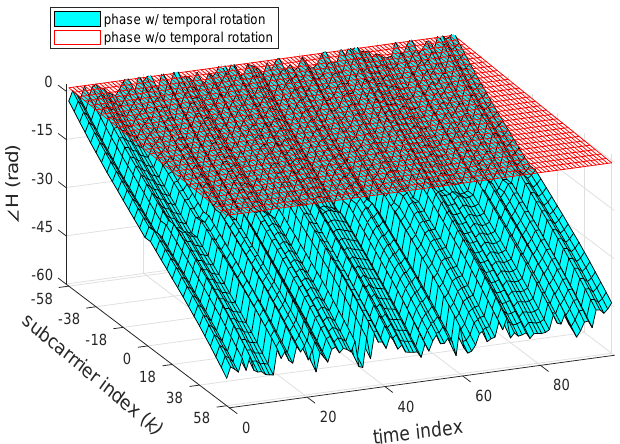
Figure 4. Effect of the temporal phase rotation to the CSI phase (cyan) in comparison with the original phase component